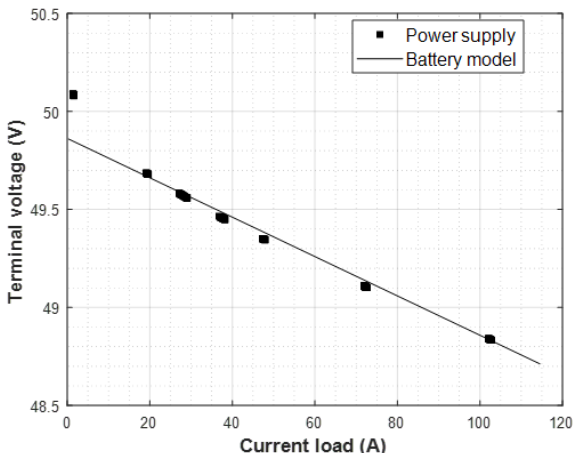
Figure 23. Terminal voltage of the battery model and the power Supply according to the current